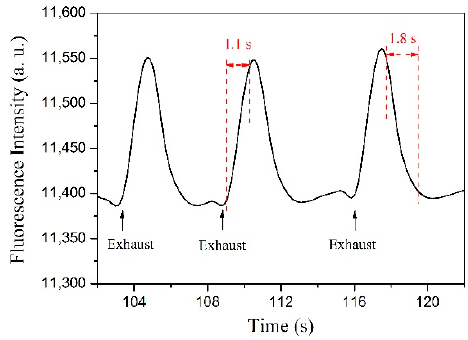
Figure 7. The results of the time response test.